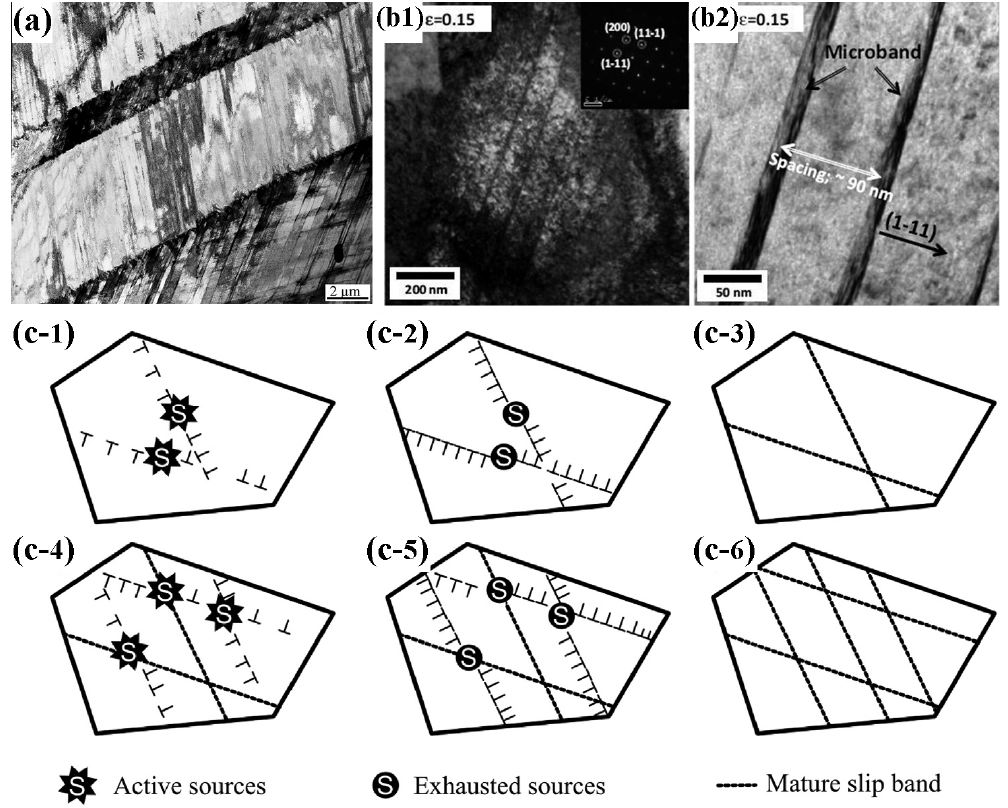
Figure 5. Three deformation mechanisms reported in high SFE Fe-Mn-Al-C steels. ( a ) shear band– induced plasticity: uniformly arranged shear bands on {111} planes within the austenitic matrix of a deformed high-Mn steel [75] (Reproduced with permission from [75]. Copyright 2016 Wiley.); ( b ) microband-induced plasticity: (b1) and (b2) well-developed microbands having distinct boundaries in austenite of the medium-Mn duplex lightweight steel at the true strain of 0.15 [51] (Reproduced with permission from [51]. Copyright 2015 Elsevier). ( c ) schematic illustration of dynamic slip band refinement: (c–1) activation of sources, (c–2) slip planes filled up with dislocations. (c–3) exhausted sources due to back stresses and fully developed slip bands, (c–4) activation of new sources, (c-5) and (c-6) newly activated sources undergone the same evolution as the previous sources leading to a refinement of the slip band substructure [97] (Reproduced with permission from [97]. Copyright 2016 Elsevier).